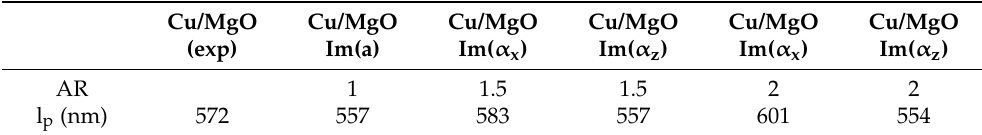
Table 1. Experimental and theoretical wavelength positions of the LSPR for Cu/MgO NPs. The results for AR = 1.5 and AR = 2 are, respectively, maxima of Im ( α x ) and Im ( α z ).